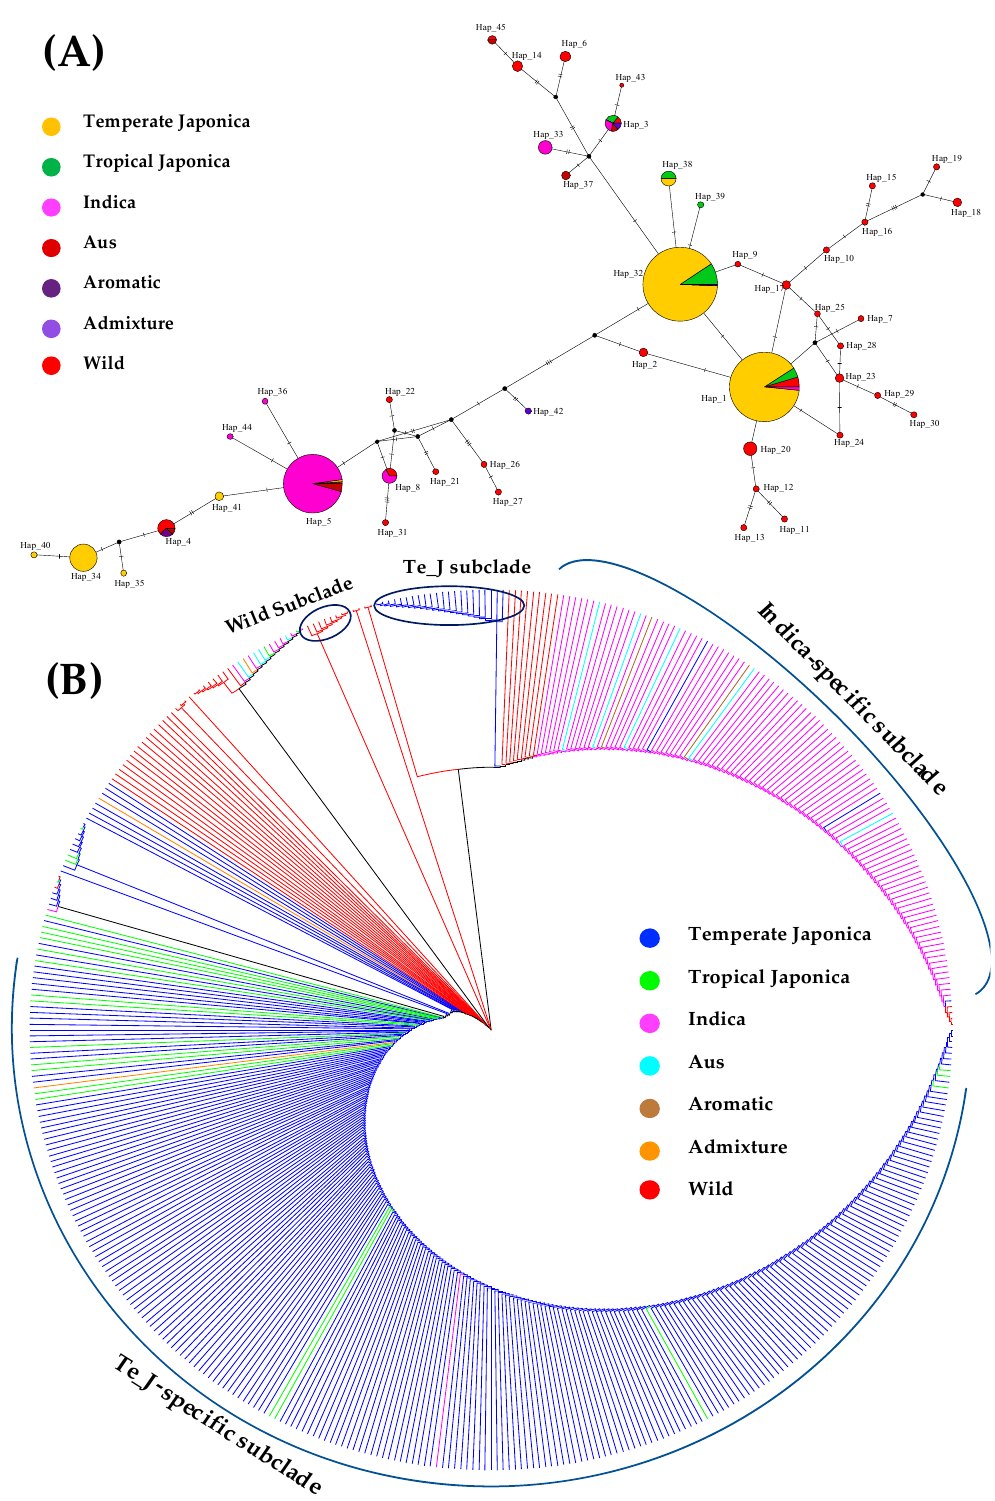
Figure 5. Haplotype-based analysis of the GBSSII ( Os07g0412100 ) gene in the 475 Korean rice accessions. ( A ) Haplotype network visualizing the evolutionary relationships among the identified haplotypes. The size of each circle is proportional to the number of accessions that harbor the haplotype, and different colors refer to the different ecotypes. Black circular dots indicate median vectors and in the present analysis, there were 20 median vectors in total. ( B ) Phylogenetic tree inferring the evolutionary relationships among the tested rice accessions, indicating their ancestral history using the neighbor-joining method. Different colors refer to different